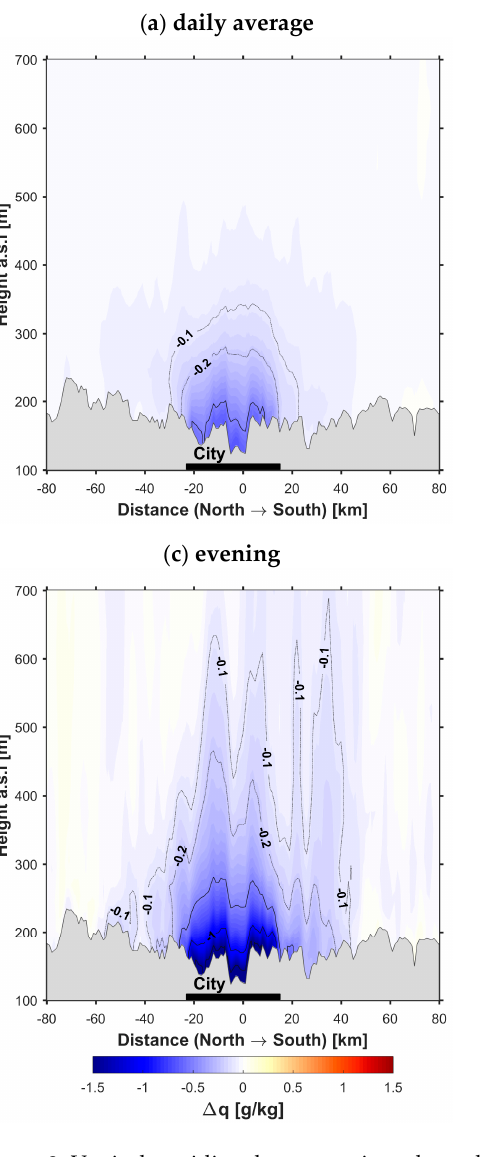
Figure 8. Vertical meridional cross-sections through the center of Moscow in the field of the modeled specific humidity response to switching on the urban canopy model ( ∆ q ): daily-mean ( a ); mean daytime (13 UTC/16 MSK) ( b ); evening (16 UTC/19 MSK) ( c ); and nocturnal (23 UTC/02 MSK) ( d )